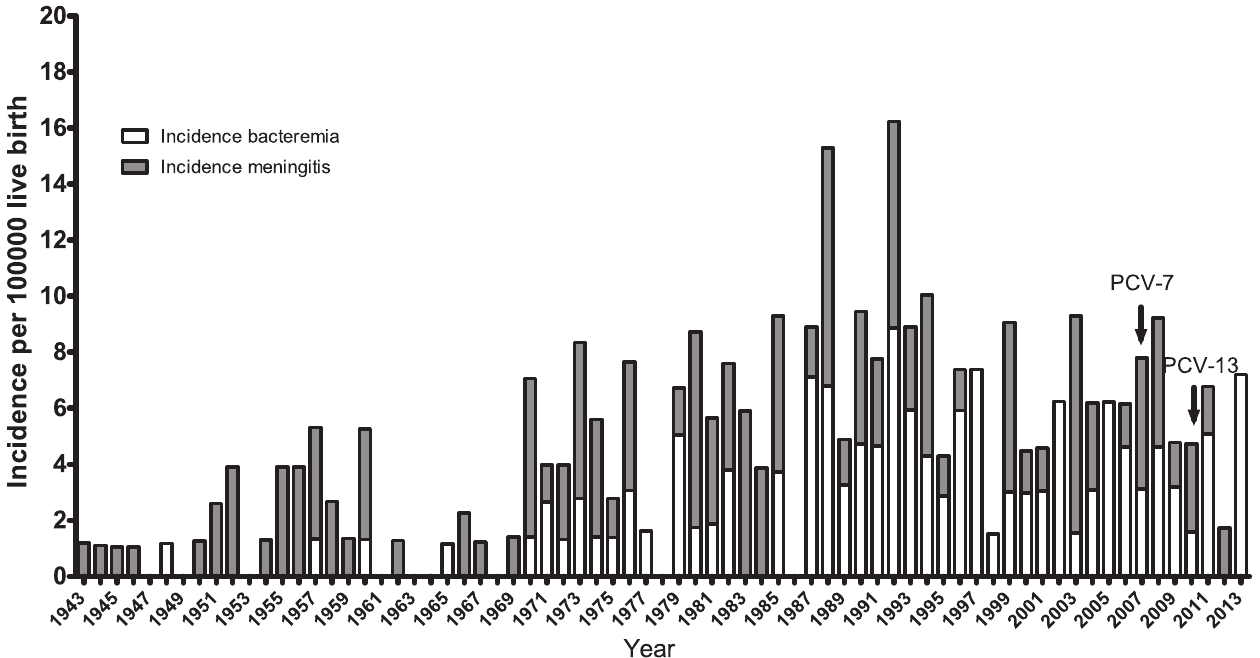
Figure 1. Incidence of IPD in infants younger than 90 days from 1943 through 2013. Grey bars: meningitis. White bars: bacteraemia. PCV-7 was introduced in October 2007 and PCV-13 was introduced in April 2010. The range of the incidence rate and Confidence Intervals (CI: 95%) for IPD was from 0–16.2 (lower CI: 0–9; upper CI 0–29.4), for meningitis 0–8.5 (lower CI: 0–3.5; upper CI 0–20.4) and for bacteraemia 0–8.9 (lower CI: 0–4.0; upper CI